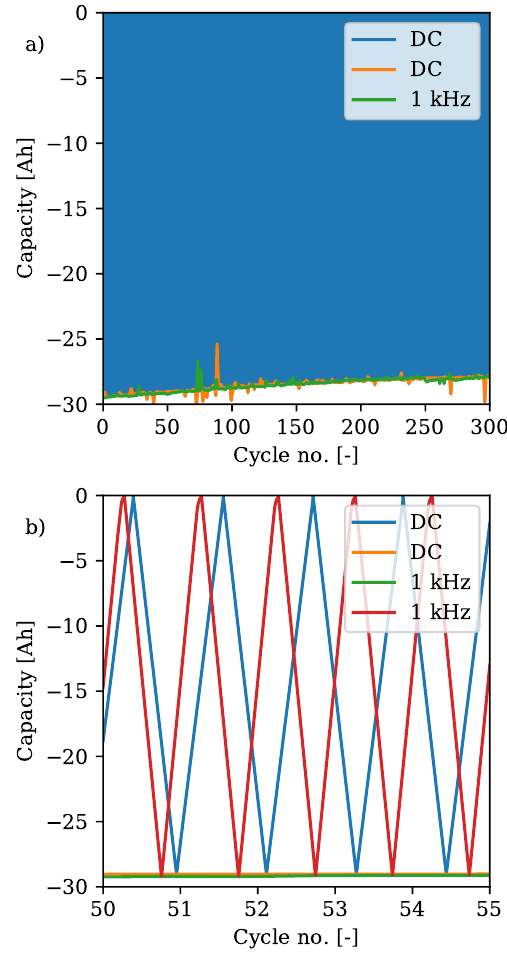
Figure 6. ( a ) Capacity and fade of peak capacity from BOL up to 300 cycles of two LIB cells cycled with and with out ac current; ( b ) Zoom of ( a